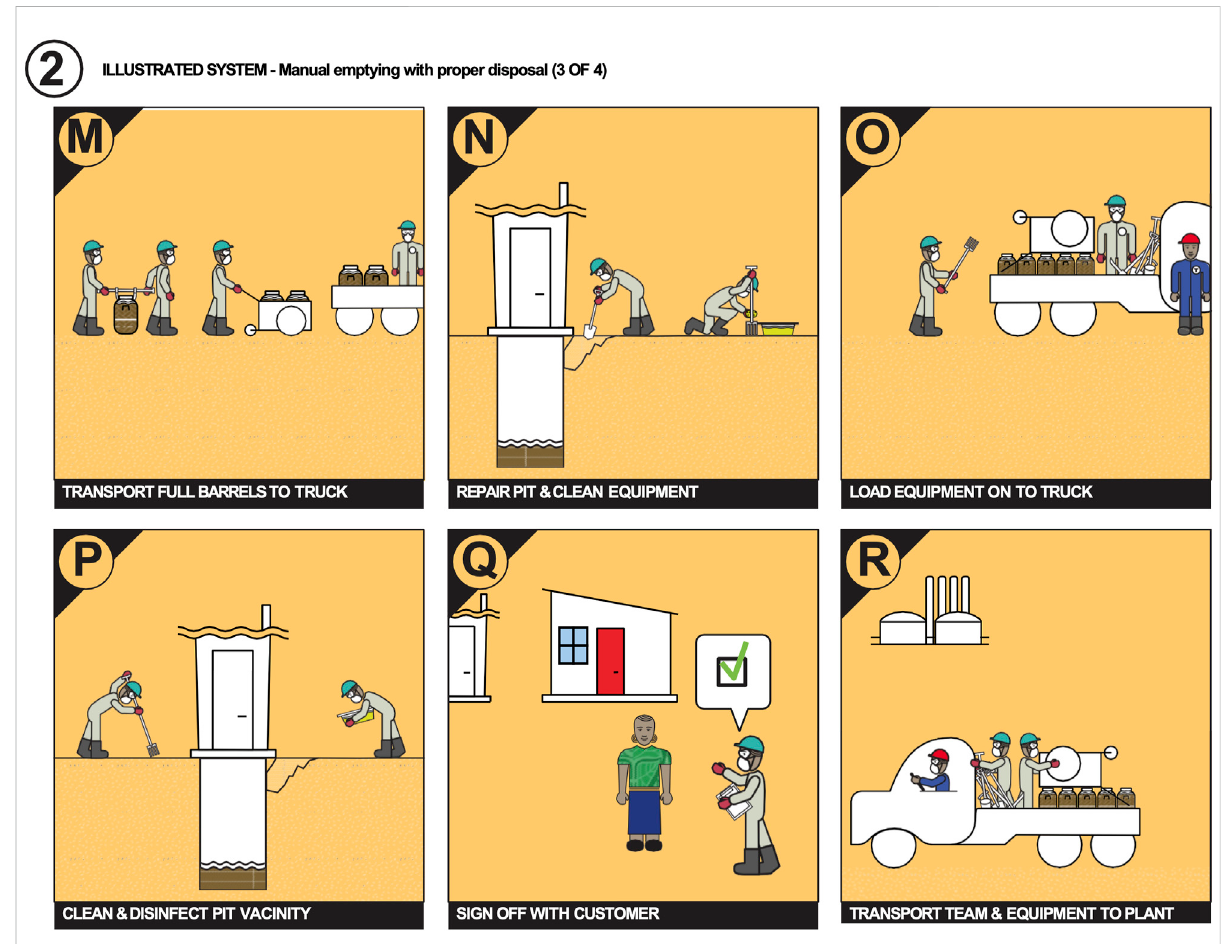
FIGURE 2 Excerpt of manual emptying with proper disposal. See Supplementary Material for the complete set. The panel labels correspond to the chronological labels used in the complete